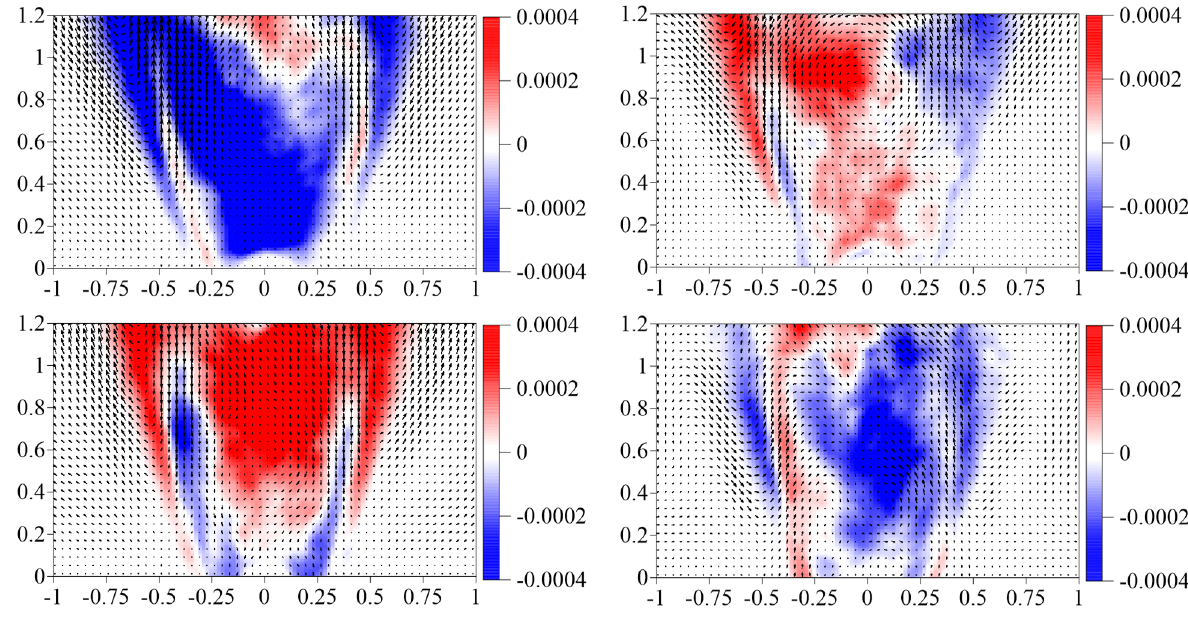
Figure 15. The first and the second POD modes with the conditionally sampled NO concentration: the first line—1 atm. 293 K; the second line—2 atm. 500 K; the third line—3.4 atm. 500 K. POD 1 POD 2 POD 1 POD 2